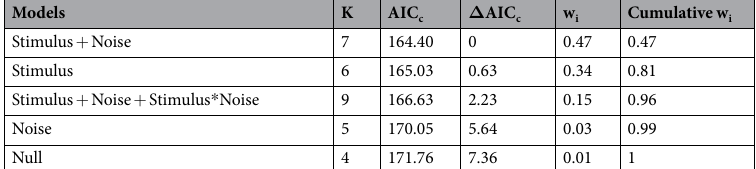
Table 2. AIC c table for playback distance.